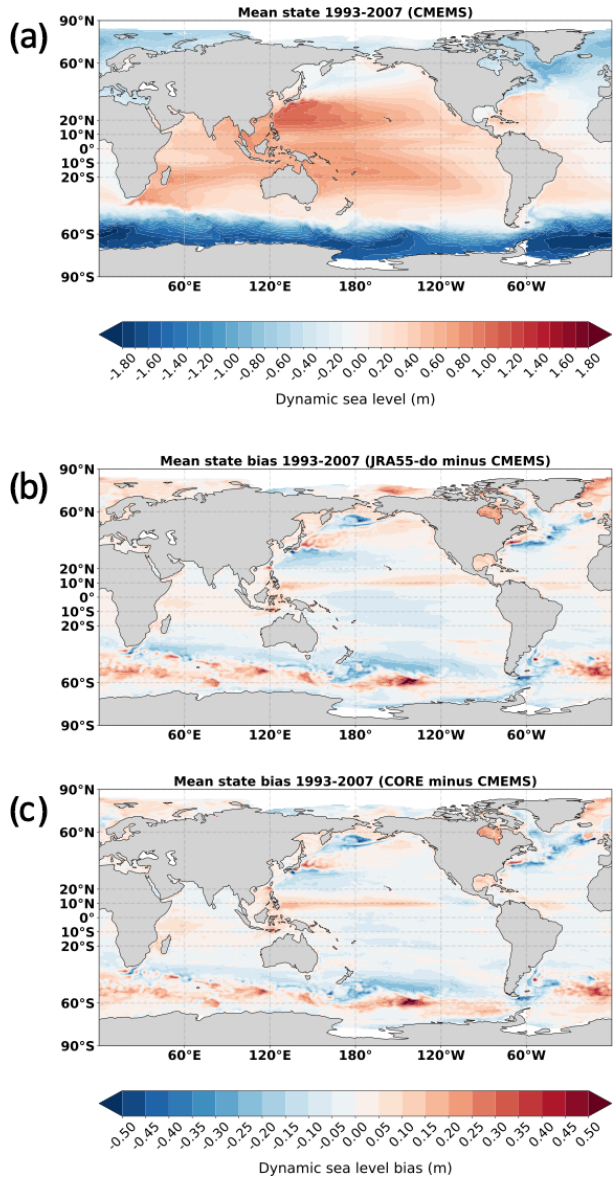
Figure 2. (a) The shaded color shows the DSL time mean (1993– 2007) from satellite altimeter measurements (CMEMS). The shaded color shows DSL bias in (b) the JRA55-do-forced simulation and (c) the CORE-forced simulation during the 1993–2007 period.